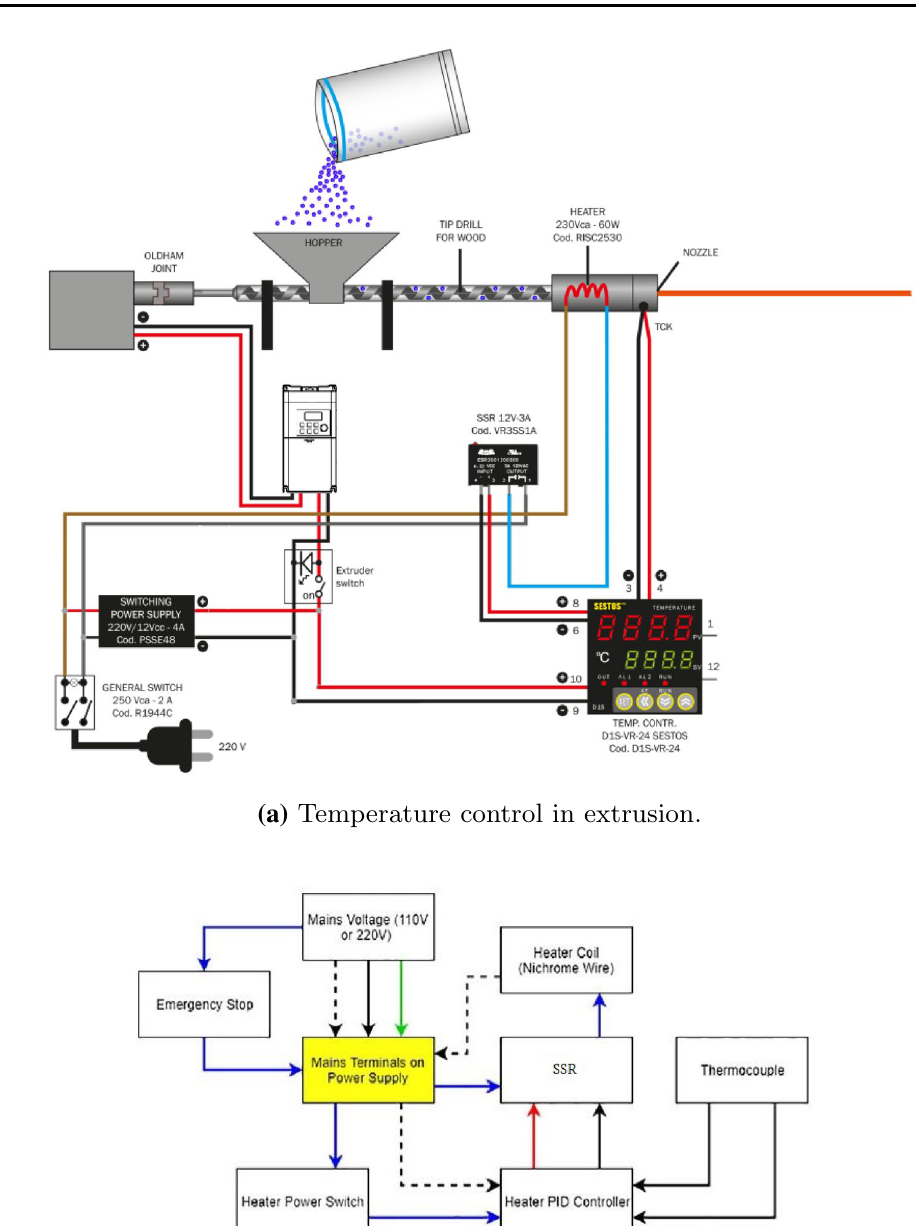
(b) Wiring diagram for the entire